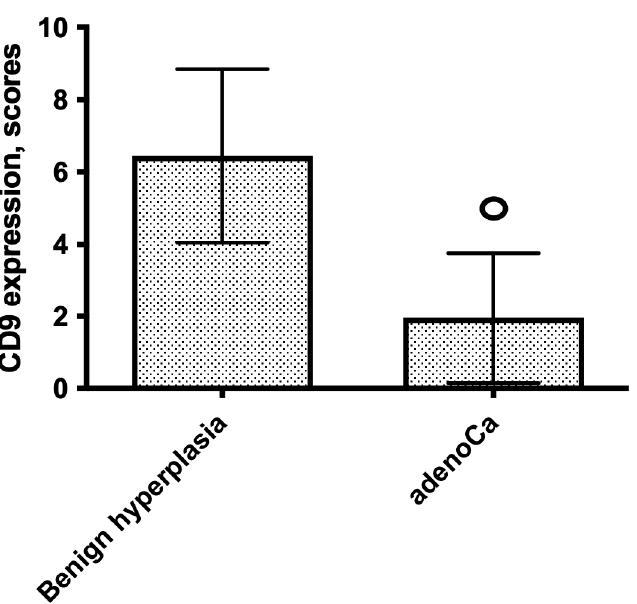
Figure 4. Comparison of CD9 expression in patients with prostate benign hyperplasia and acinar adenocarcinoma; ₒ p < 0.0001; Mann–Whitney U test.